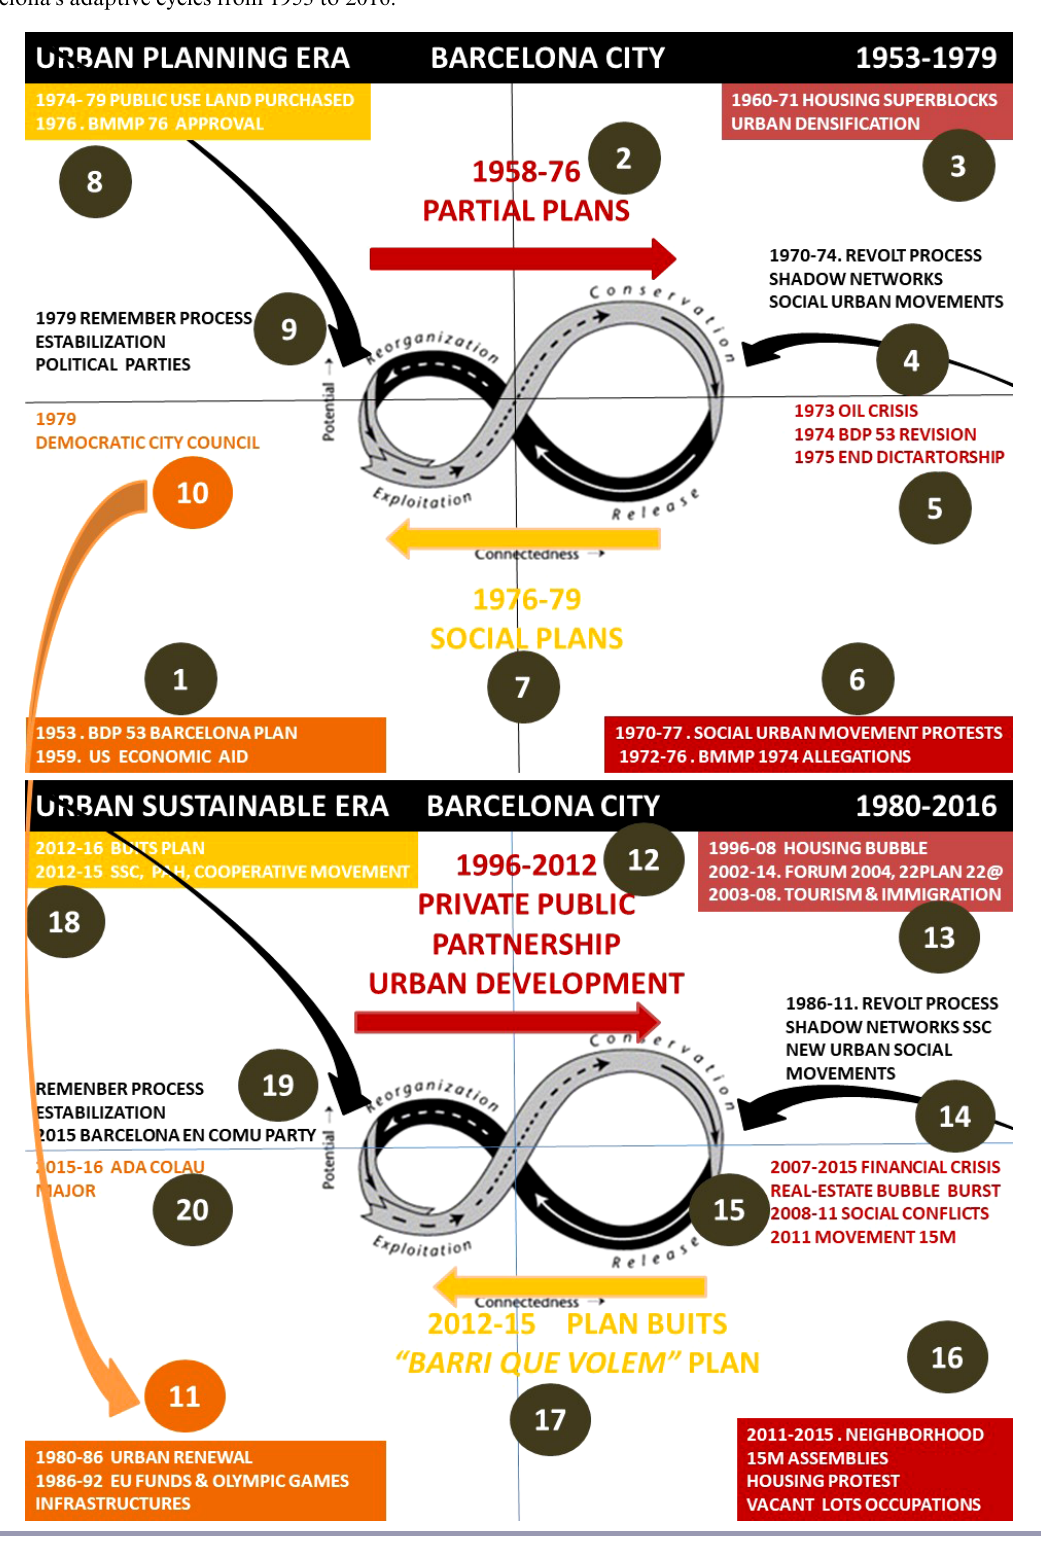
Fig. 1. Barcelona’s adaptive cycles from 1953 to